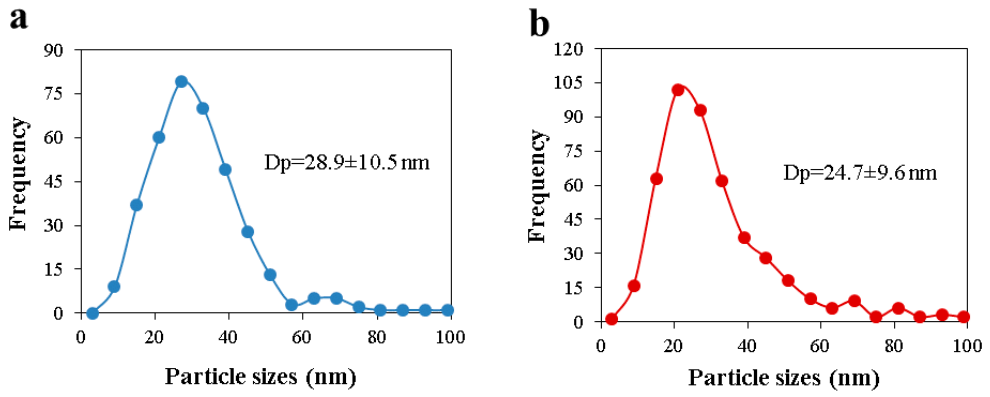
Figure 9. Particle size distribution for Fe/CAG 90 ( a ) and Ni/CAG 90 ( b ).